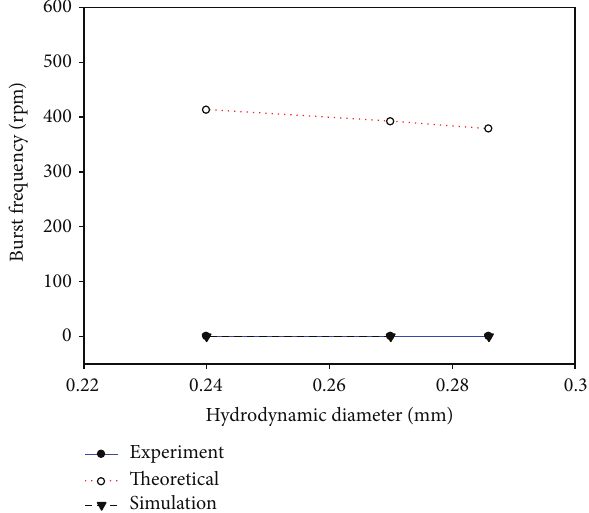
Figure 14: Burst frequency varies with a larger hydrodynamic diam- eter when the type of titrant is oil.